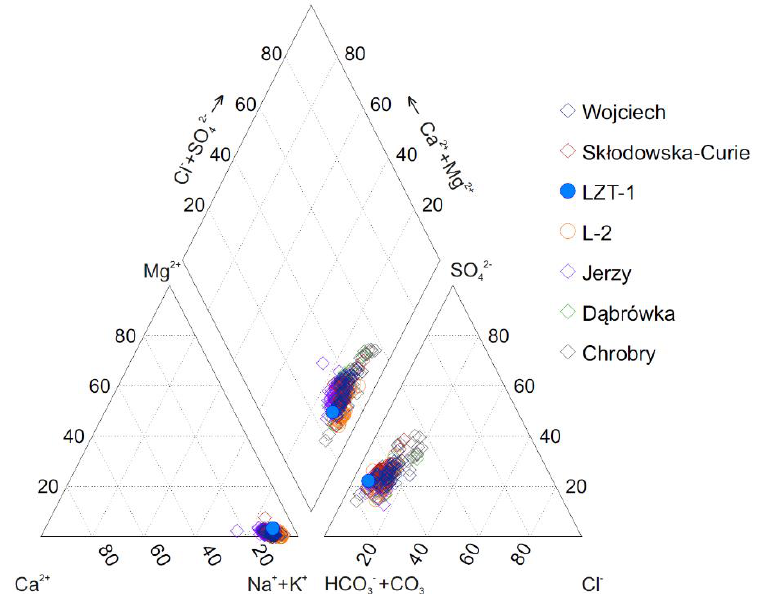
Figure 5. Chemical composition of the Lądek-Zdrój thermal waters on a Piper diagram (based on [79] updated).